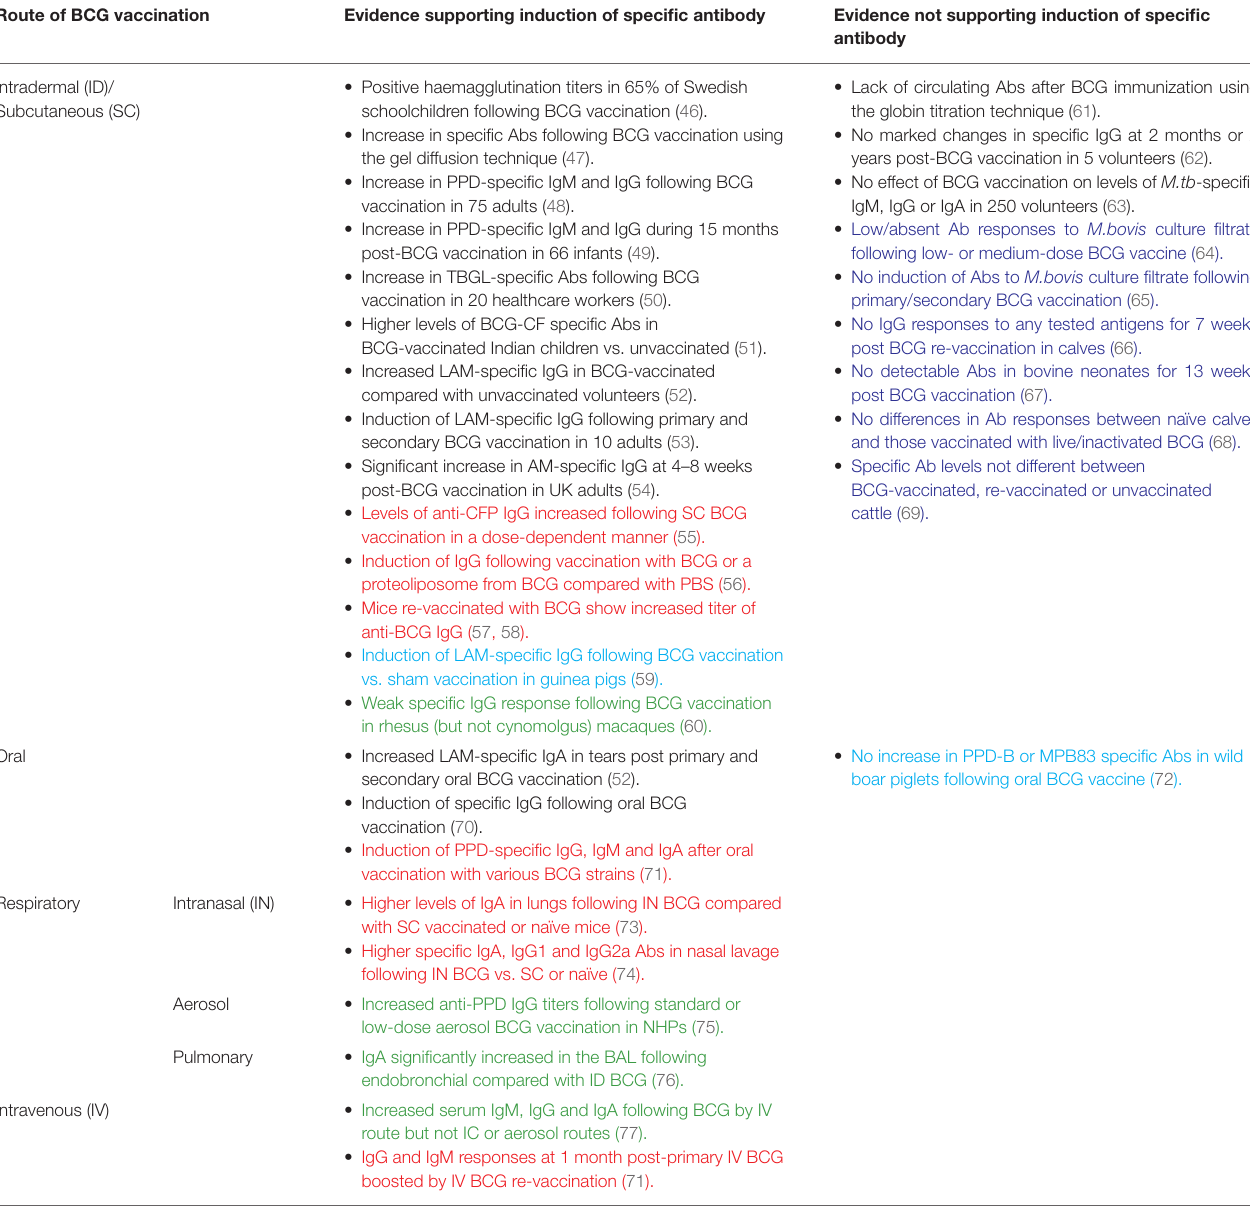
TABLE 1 | Summary of studies discussed in this review measuring specific antibody responses to BCG by route of administration. Route of BCG